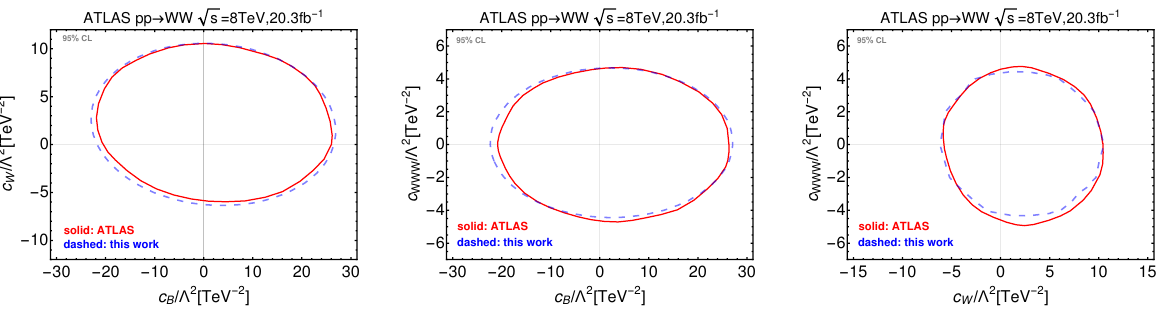
Figure 14 . Comparison between the 95% CL contours obtained by the ATLAS collaboration [38], and the results we obtained recasting their